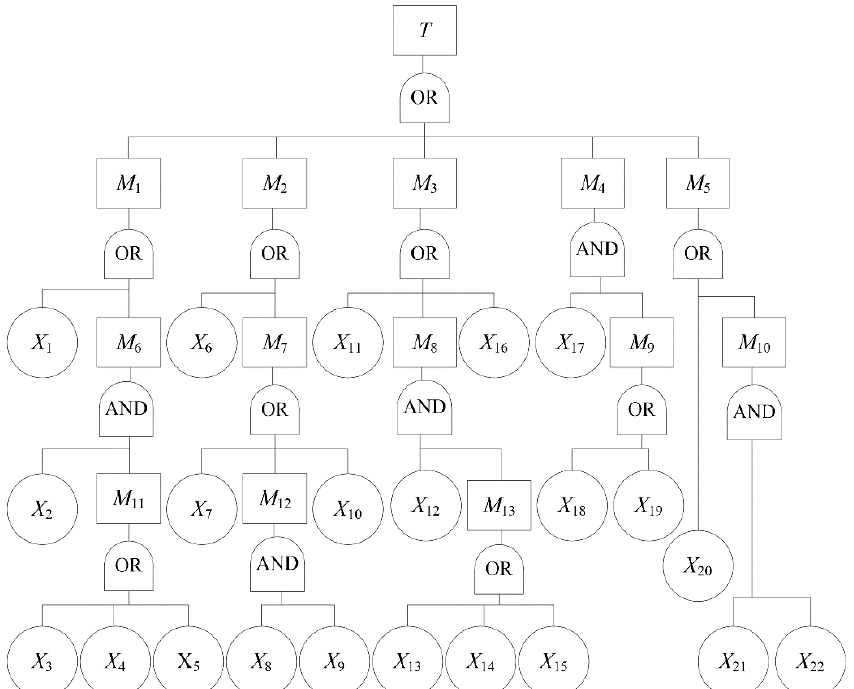
Figure 3. Fault tree of hydraulic support failure.